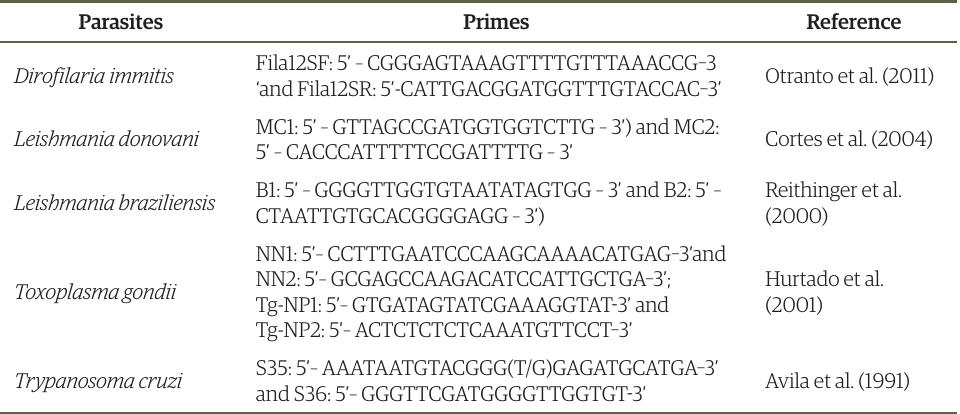
Table 1. Primers used in this